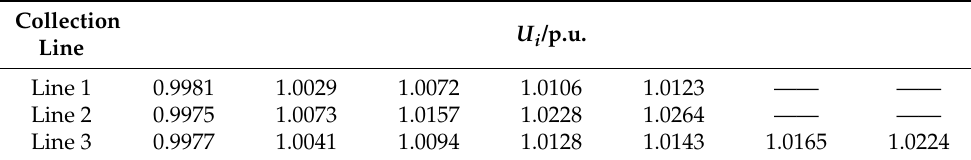
Table 1. The generator terminal voltage distribution in the wind farm at 2